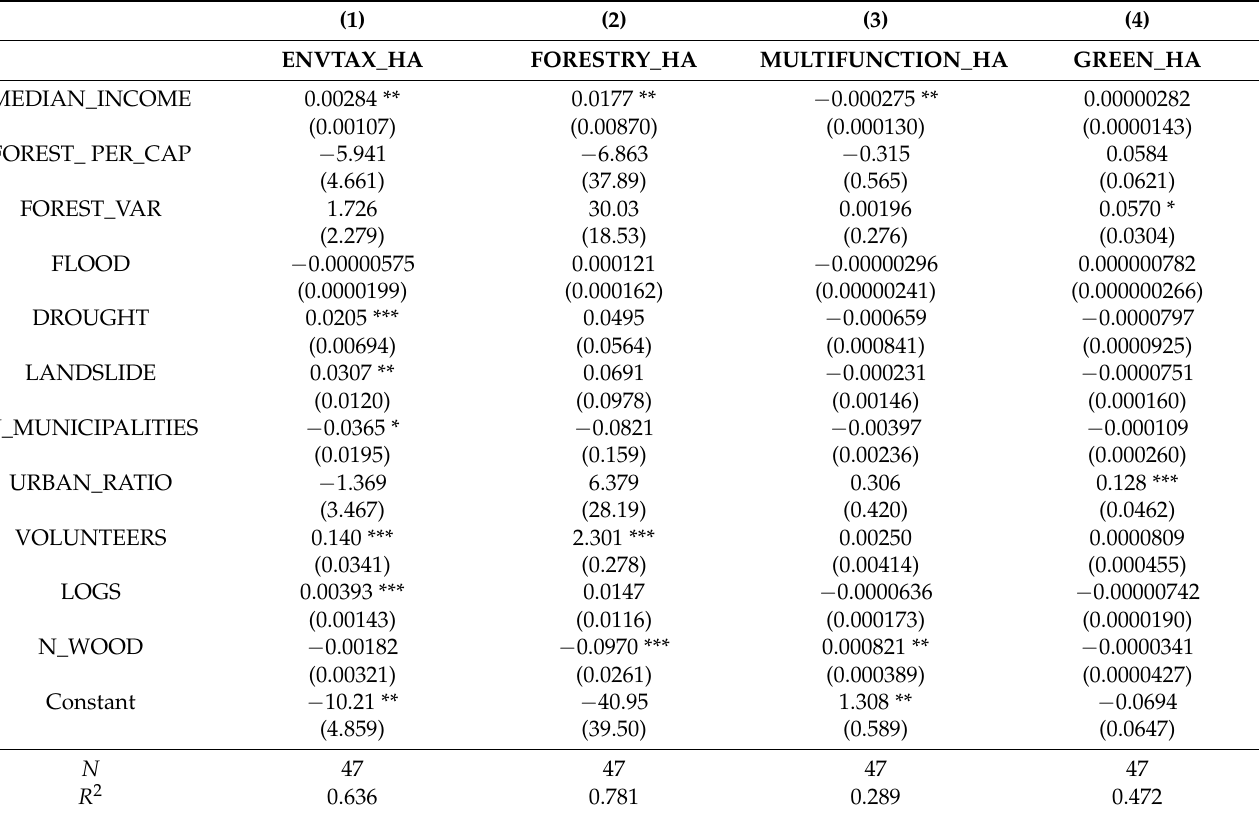
Table 3. The SUR results of the median voter models.